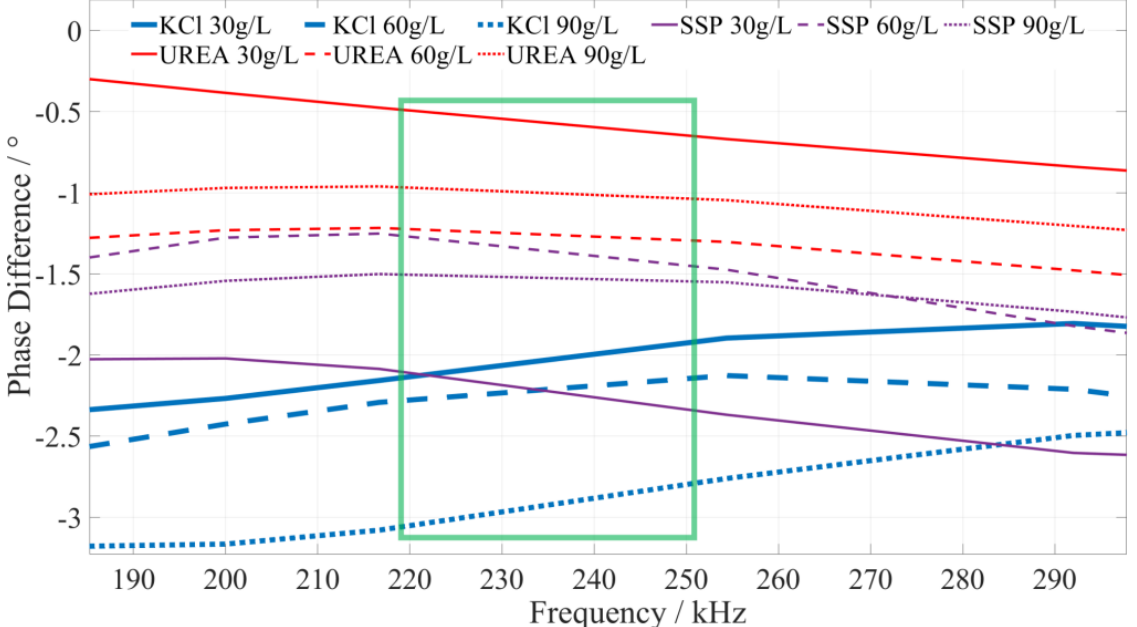
Figure 6. The phase – frequency characteristic curve of the potassium chloride, urea, and superphos- Figure 6. The phase–frequency characteristic curve of the potassium chloride, urea, and superphos- phate fertilizer solutions under the excitation signal of 220~250 phate fertilizer solutions under the excitation signal of 220~250 kHz.